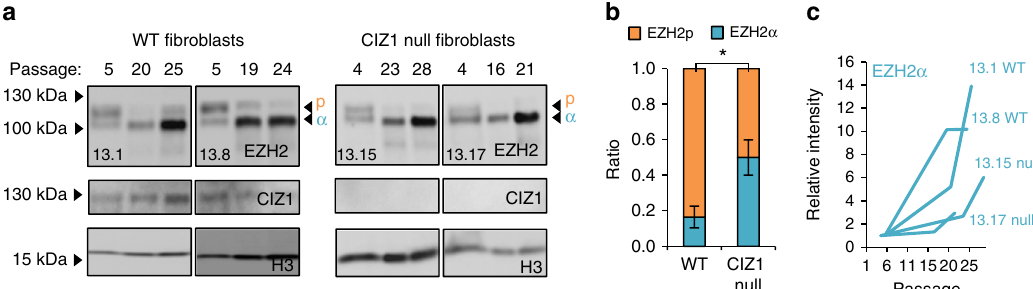
Fig. 5 Loss of CIZ1 drives changes in EZH2 isoform. a Western blot showing PRC2 catalytic subunit EZH2 (antibody D2C9) in representative primary embryonic fi broblasts and derived culture-adapted populations, of WT and CIZ1 null genotypes, showing two prominent isoforms in early passage cells, designated p and α . Relative af fi nity for these isoforms varies between commercially available anti-EZH2 antibodies (Supplementary Fig. 3). b Quanti fi cation of isoforms p and α in early passage WT and CIZ1 null cells, showing mean ratio for three independent populations of each type (WT; 13.1, 13.8, 14.4, CIZ1 null; 13.15, 13.17, 14.2), ±SEM, signi fi cant changes are indicated ( t -test). c Quanti fi cation of EZH2 α in primary cells and derived